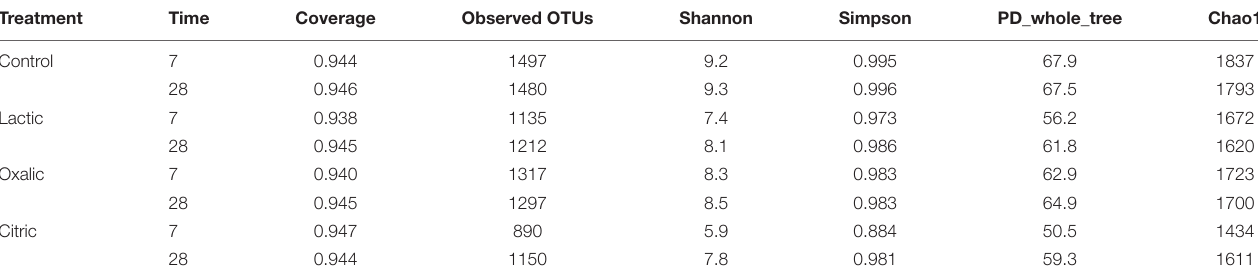
TABLE 2 | α -Diversity indices of soil